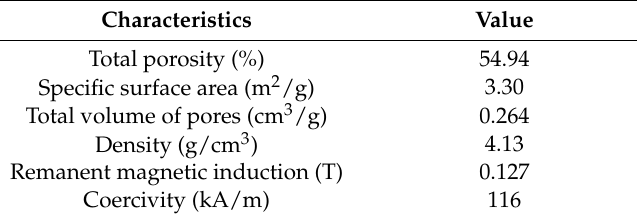
Table 1. Characteristics of strontium ferrite.